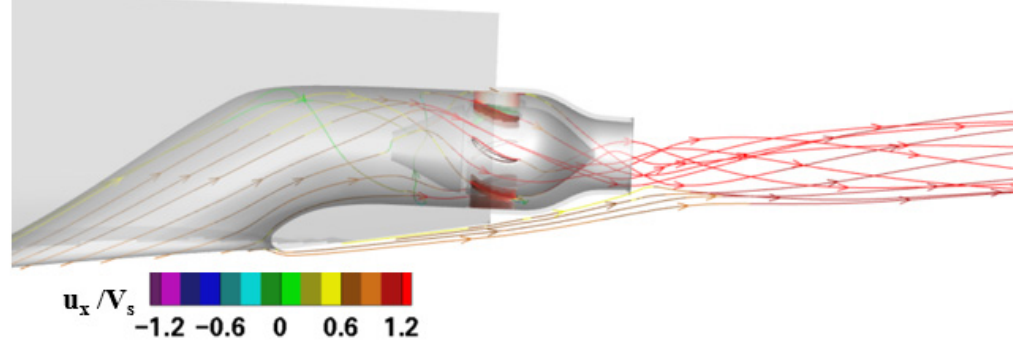
Figure 15. The streamlines in the inner of the waterjet propulsor.